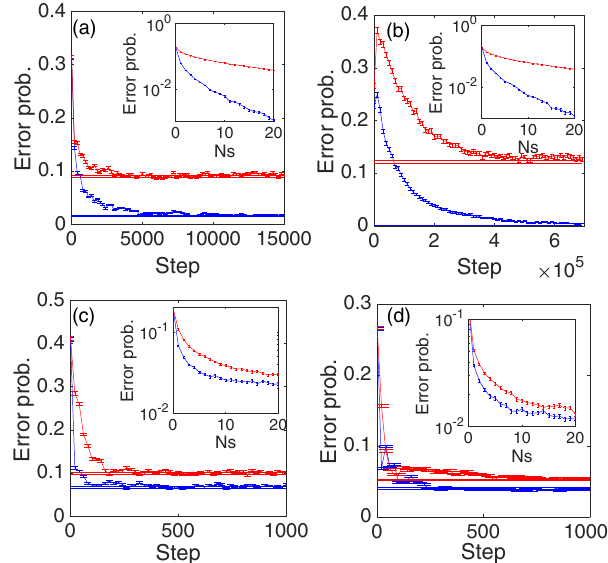
FIG. 4. Training process and performance for SVM. Data points with error bars show the performance of the SVM; horizontal straight lines show the performance with the perfect hyperplane w given with (cid:3) 1 standard deviation. The red plots are t for classical SVM, and the blue plots are entanglement-assisted SVM. Insets: The scaling of the error probability of the optimum hyperplane with respect to the mean photon number N . S 5 ; α 2 ; M ¼ 10 . Number of data points (a) η ¼ 1 , N 0 ¼ S ¼ 20 ; α 2 ; M ¼ 100 , N ¼ 10 3 , ϵ ¼ 0 . 1 . (b) η ¼ 1 , N 0 ¼ S ¼ 1 ; α 1 . 5 ; M ¼ 3 , N ¼ 10 4 , ϵ ¼ 0 . 1 . (c) η ¼ 0 . 9 , N 0 ¼ S ¼ 1 ; α 2 ; M ¼ 2 , N ¼ 500 , ϵ ¼ 0 . 2 . (d) η ¼ 0 . 9 , N 0 ¼ S ¼ N ¼ 500 , ϵ ¼ 0 . 2 . In each training step, the channel is randomly chosen from N data points, and thus the total training steps can be larger than N